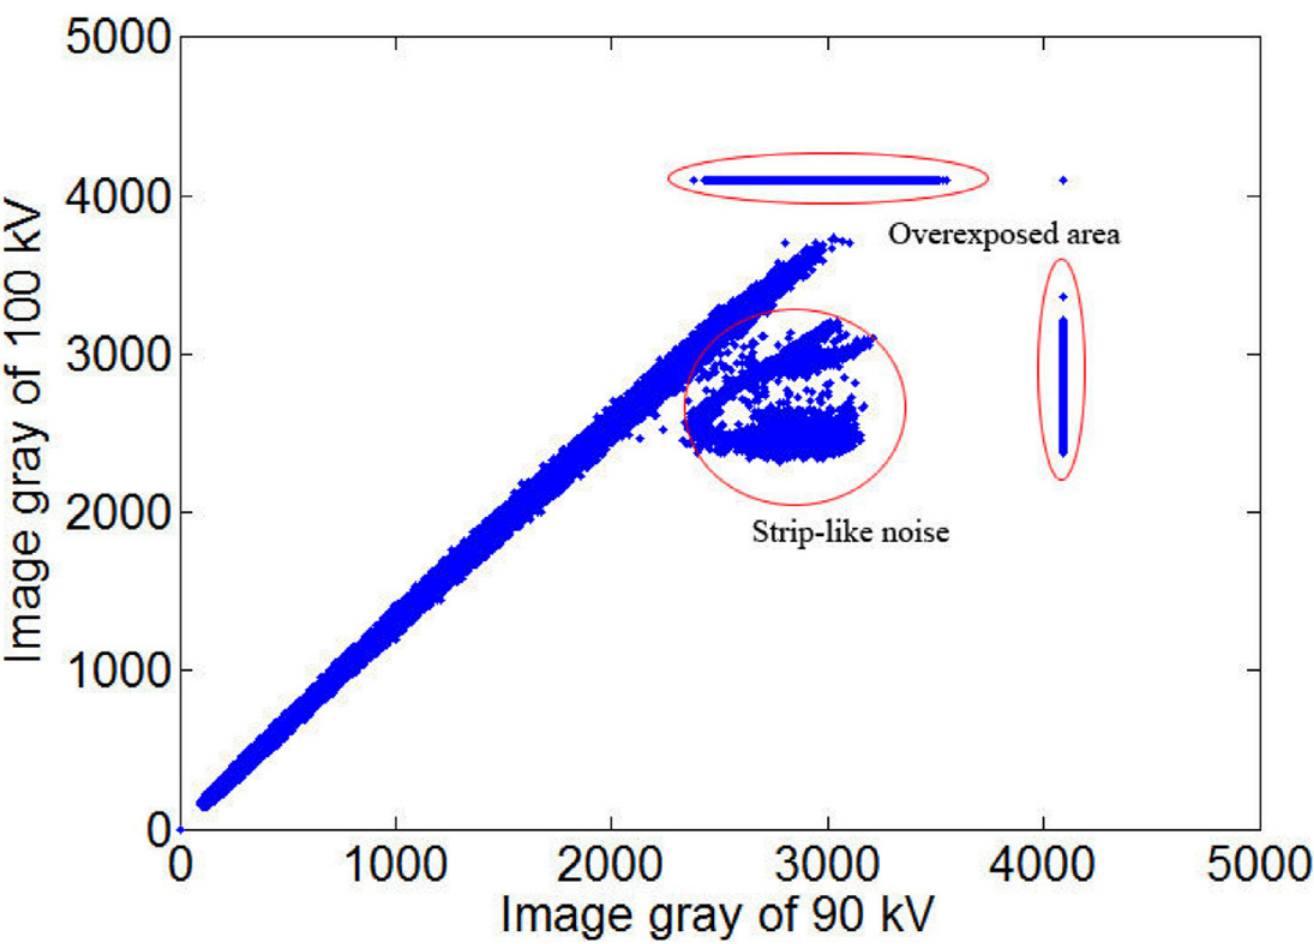
Fig 6. The corresponding gray figure between 90kV and 100 kV at 0°. Horizontal axis represents the gray of one tube-voltage image, and vertical axis represents the next tube-voltage. These points represent the gray of one point about object in the adjacent two frames